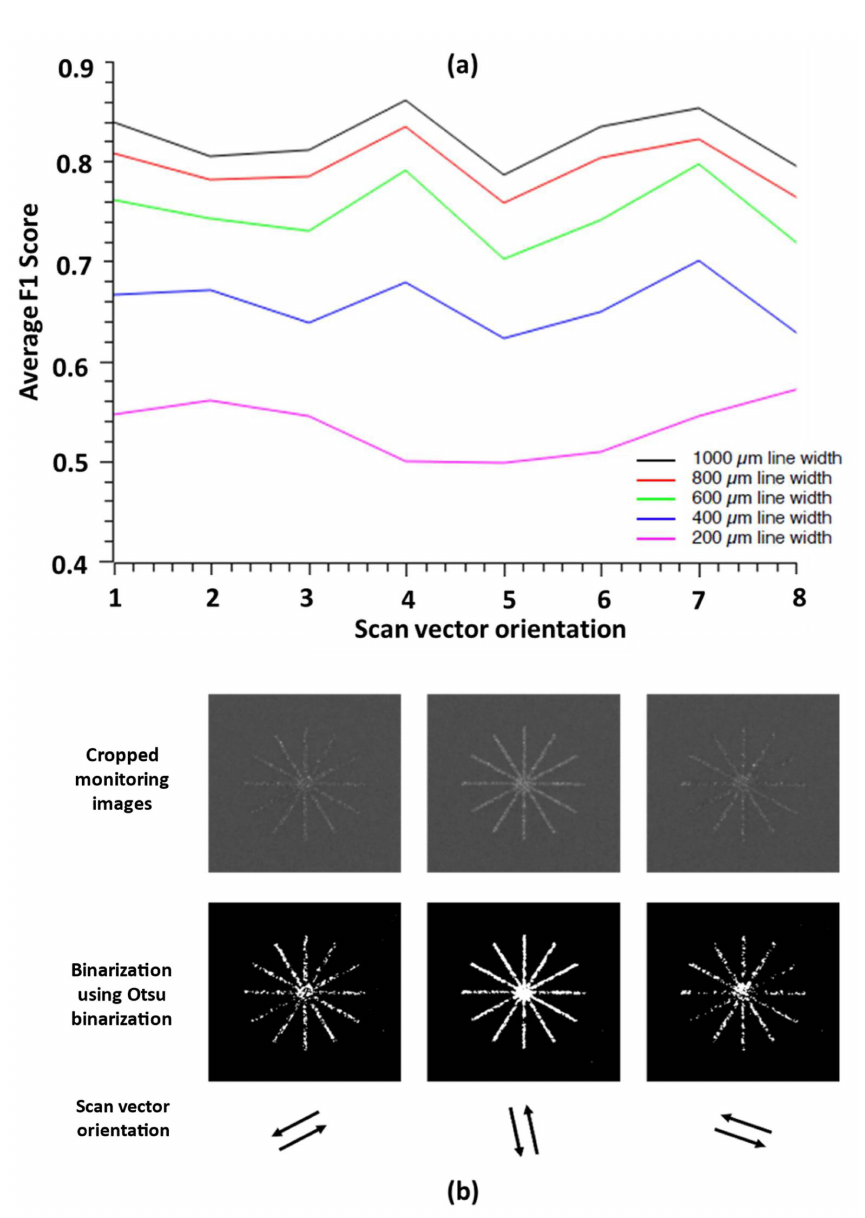
Figure 8. ( a ) F1 score with different scan vector orientations; ( b ) Monitoring images of part 2 with different scan vector orientations and their